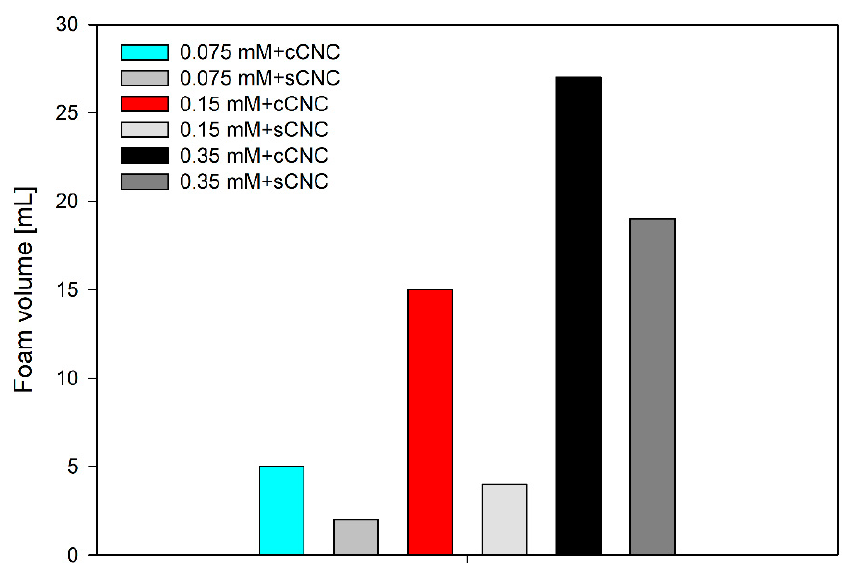
Figure 9. Initial foam volume obtained from 15 mL of LAE ‐ cCNC or sCNC dispersed with double ‐ syringe method. Foam volume was recorded 1 min after the foaming cycle.